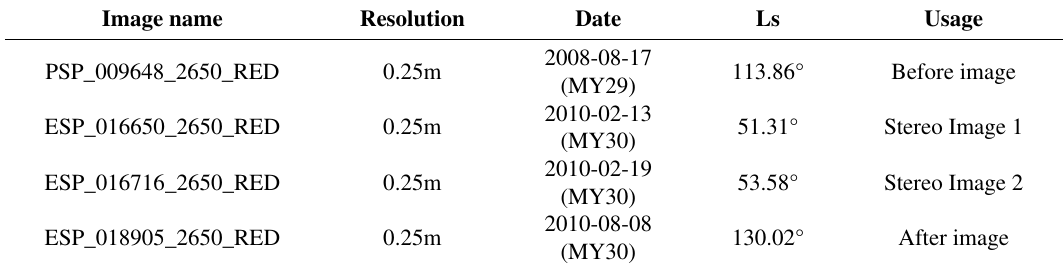
Table 1. The research data list. MY means Mars Year. Ls is the solar longitude.